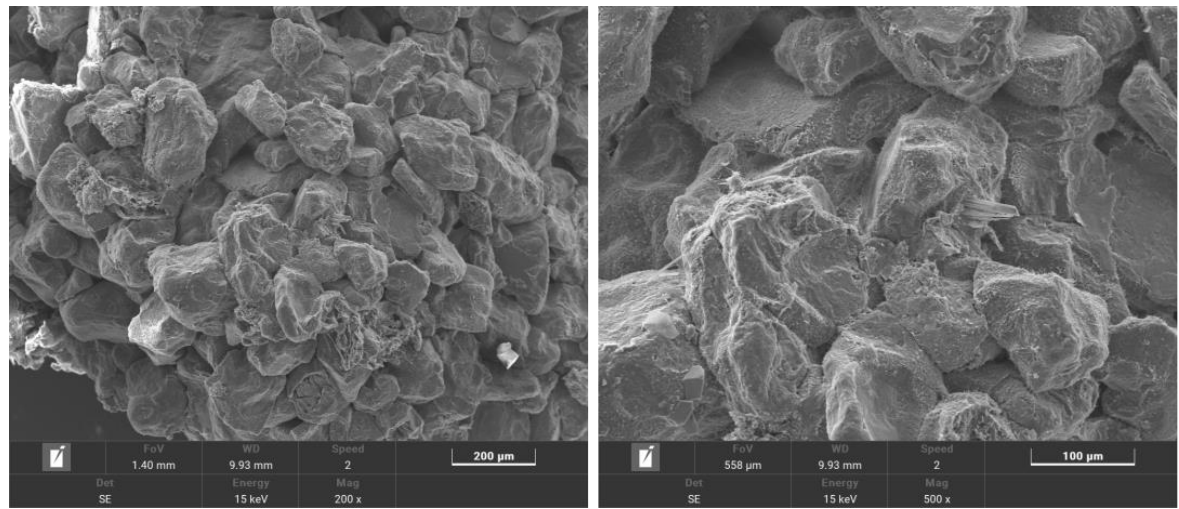
Figure 2. Microcosmic appearance.